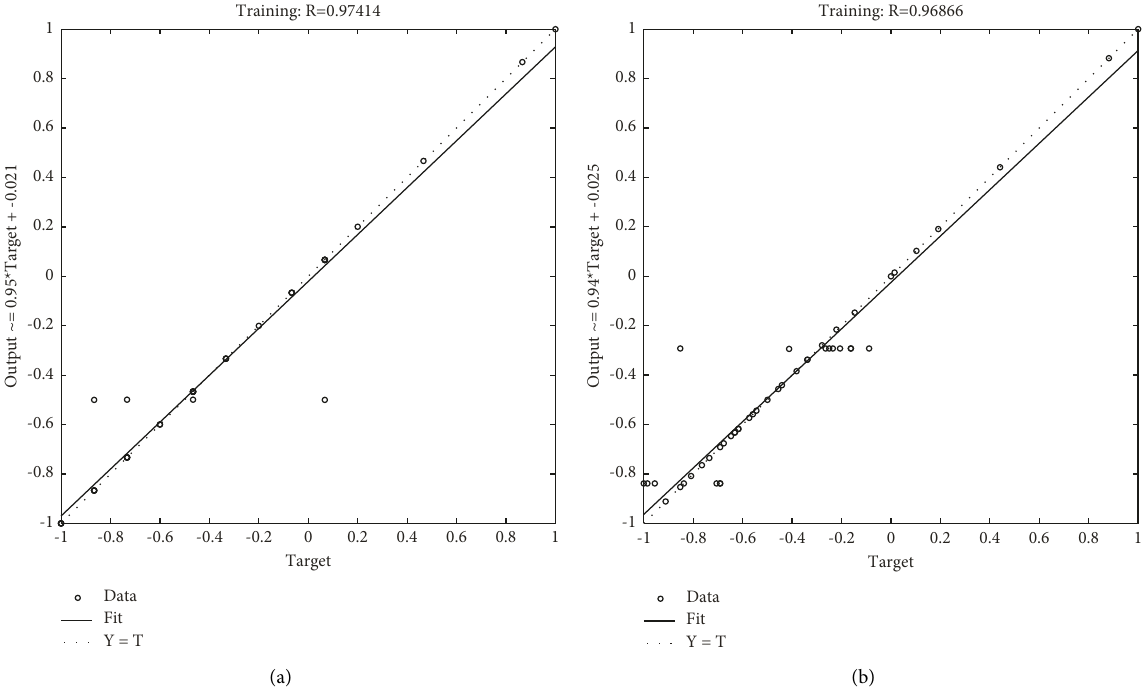
Figure 8: Accuracy of neural network training for scenario (2). (a) shows online shopping and (b) shows offline